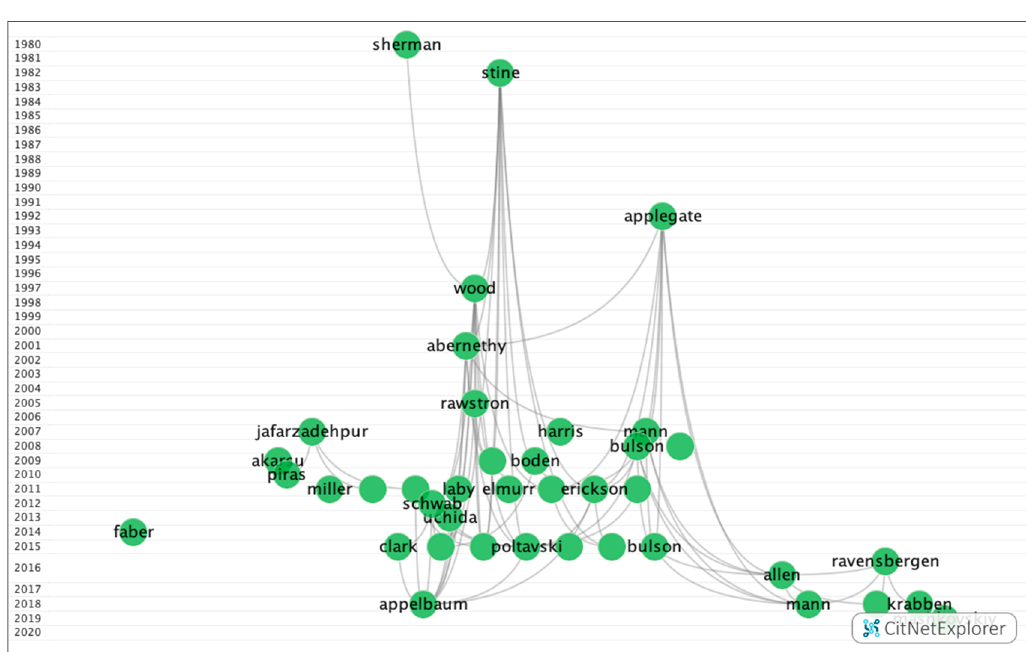
Figure 5. Citation network in group 2.